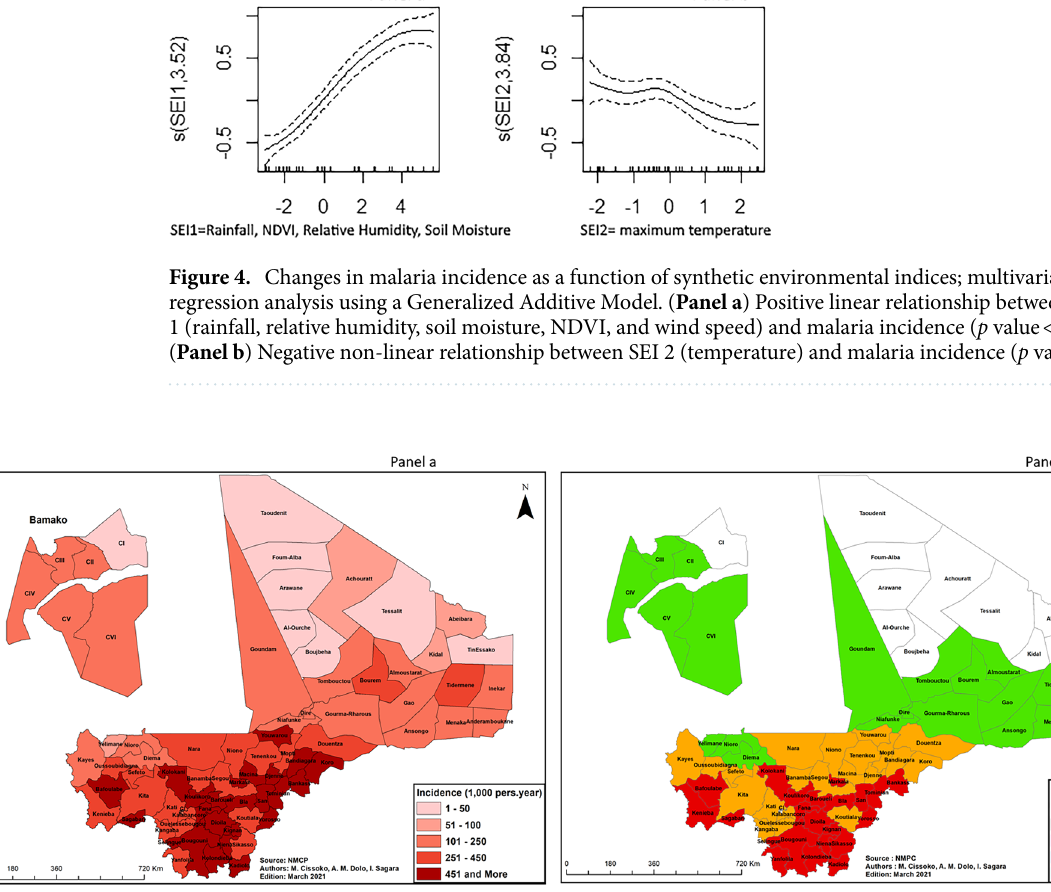
Figure 5. Annual malaria incidence adjusted for health facility usage rate in 75 health districts Mali, 2019. ArcGIS Desktop version 10.8 software (Environmental Systems Research Institute (ESRI), 380 New York Street, Redlands, CA 92373-8100, USA, https:// www. esri.